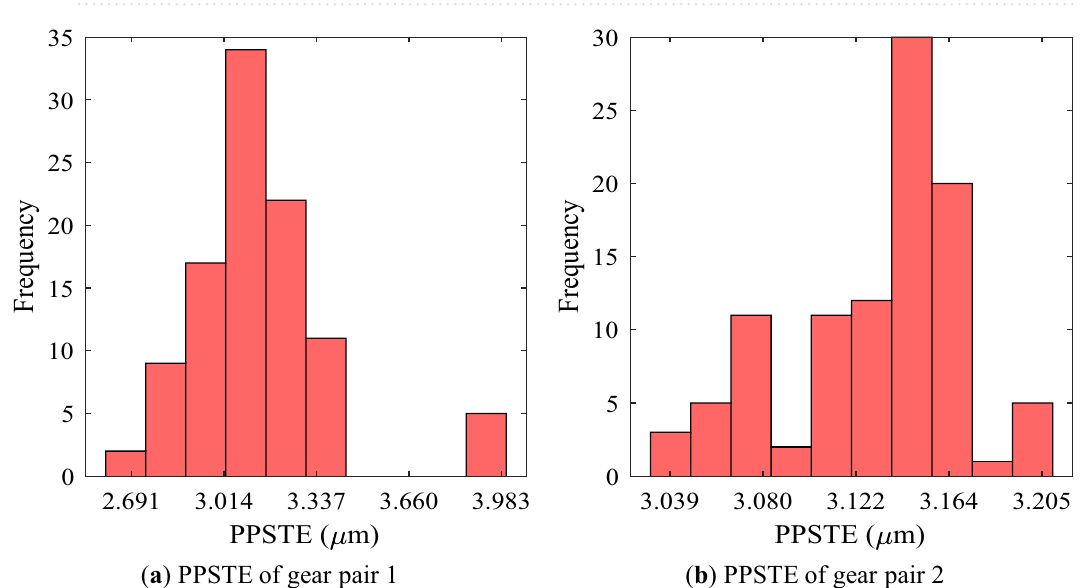
Figure 6. Frequency distribution of efficiency of each gear pair using random robustness analysis.